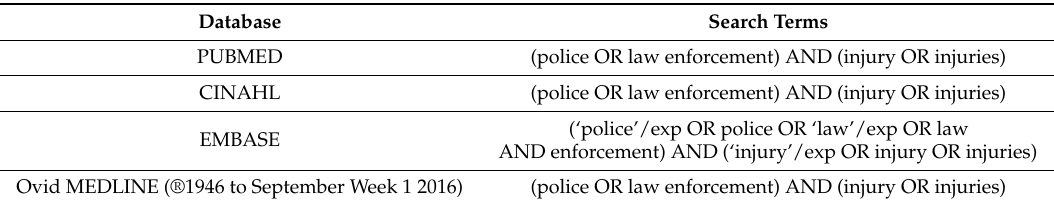
Table 1. Details of literature search: databases used and search terms (completed on 16 September